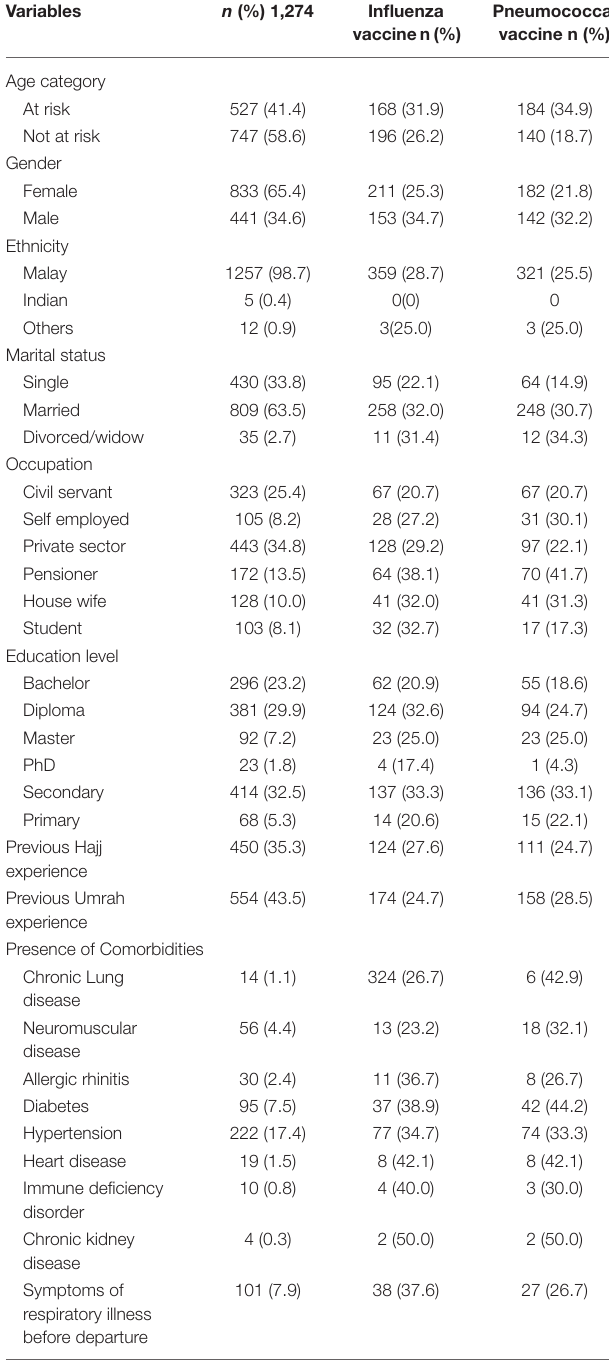
TABLE 1 | Demographic data of participants and their vaccines uptake.